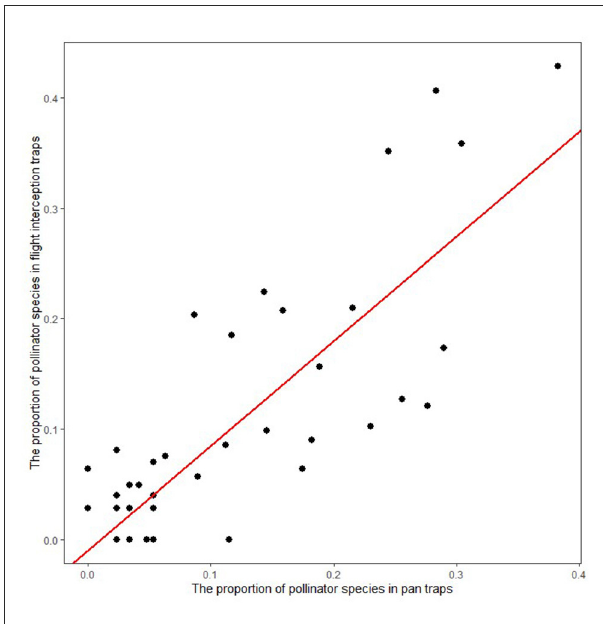
FIGURE4 The relationship between the proportion of pollinator species in PTs and